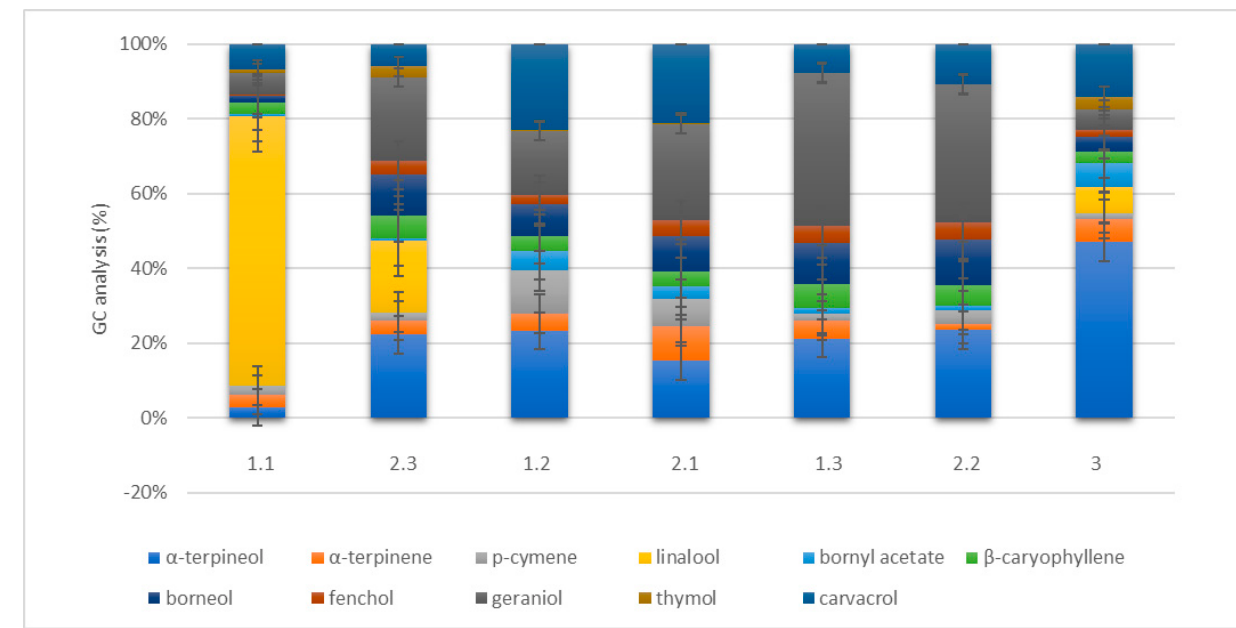
Figure 2. The component composition of essential oils of species of the genus Thymus under different growth conditions. Legend: 1.1—population of the Th. Serpyllum in the community of meadow-steppe vegetation on the crystalline outcrops of the Bila skelja near the village of Lelehivka in Roztochchja (Yavoriv National Park) (chemotype L/K/G); 1.2—population of the Th. Serpyllum in a community of psamophilous vegetation on the outskirts of the village of Strach (chemotype K/ α -T-neol/G /p-C/B); 1.3—population of the Th. Serpyllum in a community of psamophilous vegetation in a pine forest meadow near the village of Trostyanets, Mykolaiv district (chemotype G/ α -T-neol /B/K); 2.1—population of the Th. Pulegioides of grass-herbaceous vegetation on the eastern outskirts of the city of Pustomyty (chemotype K/G/ α -T-neol/ α -T-nen/B/p-C); 2.2—population of the Th. Pulegioides of grass-herbaceous vegetation near the village of Yameljnya (Yavoriv National Park) (G/ α -T-neol /B/K chemotype); 2.3—population of the Th. Pulegioides in the community of meadow-steppe vegetation in the Havrylove tract near the village of Vereshchytsja (Yavoriv National Park) (G/ α -T-neol/L/B); 3—population of the Th. Marschallianus collected on Pishchana Gora (Lion Mountain) in the “Znesinnja” RLP, Lviv ( α -T-neol/K/L/ α -T-nen/G/B-at chemotype).